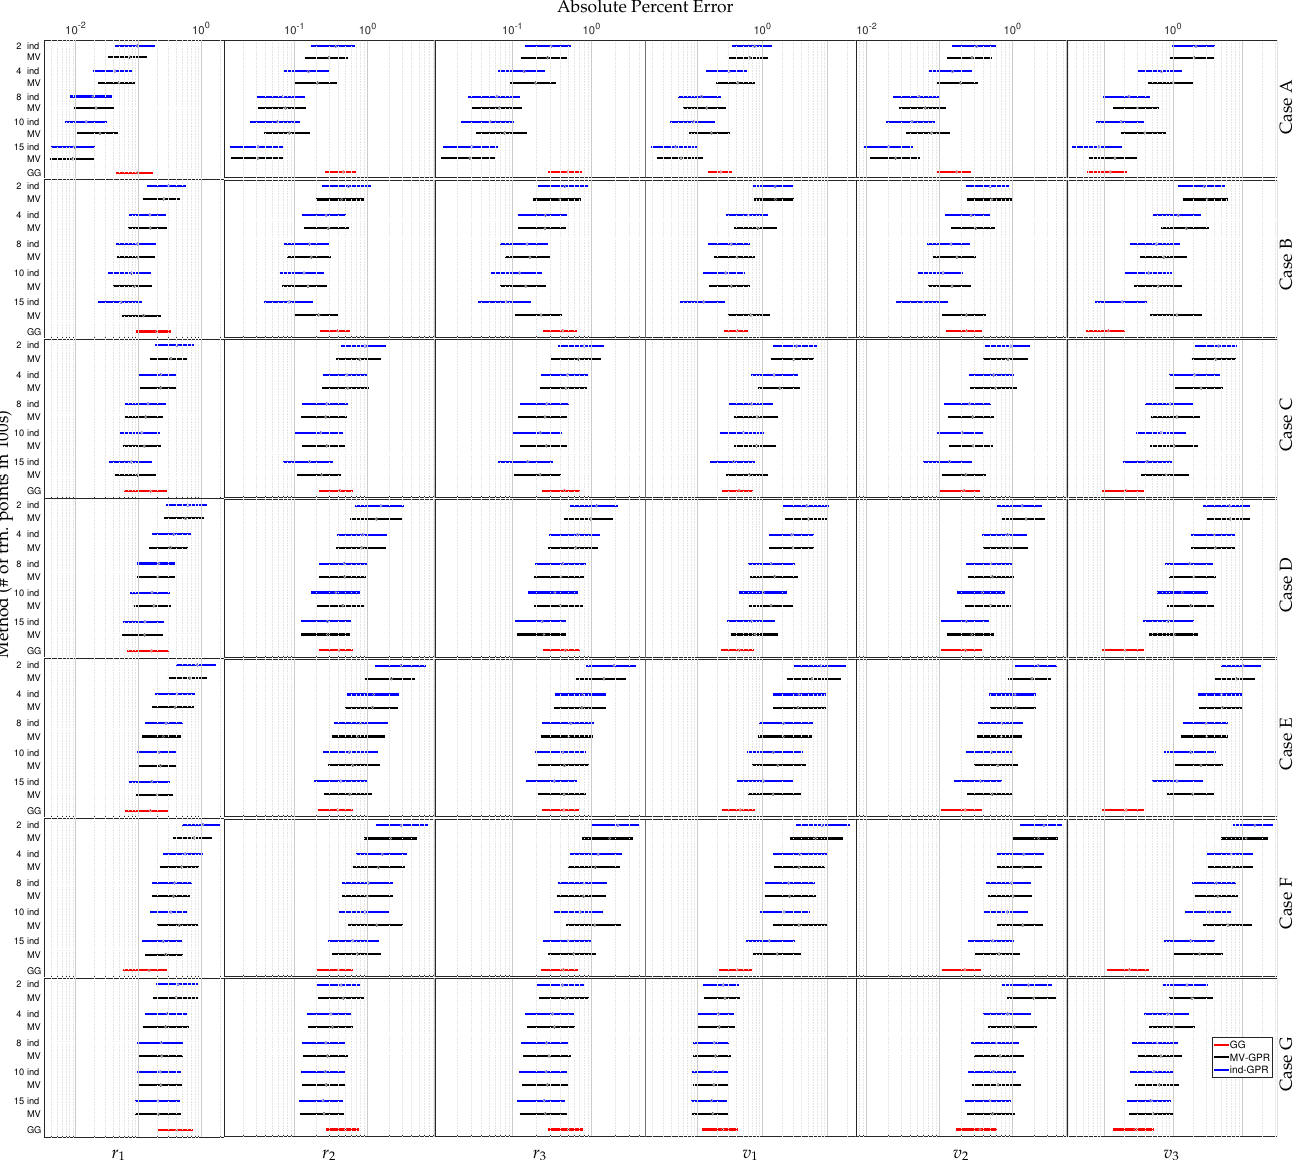
Figure 4. Given the 5000 testing orbits, the point represents the median APE while the boxes enclose the range of points between the 25th and the 75th quantiles of APE for each Cartesian state given perfect RA and DEC measurements. The GPR methods are listed ind-GPR (blue) then MV-GPR (black) and are ordered by number of training points—200, 400, 800, 1000, and 1500—listed in 100 s. The Gauss–Gibbs results are labeled GG and shown in